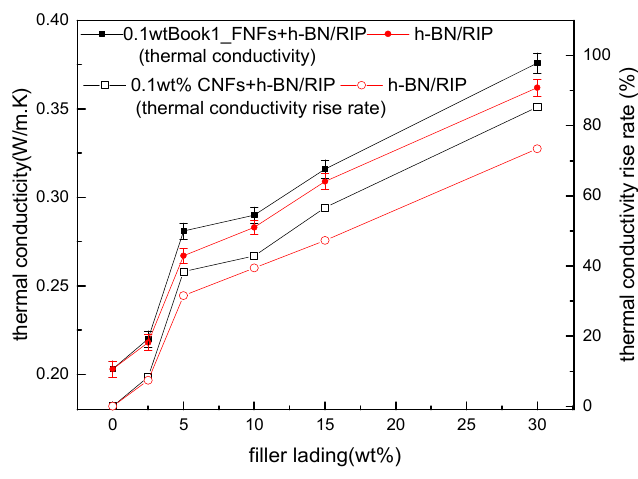
Figure 4. Relationship between thermal conductivity of resin-impregnated insulating paper (RIP) and h-BN content .